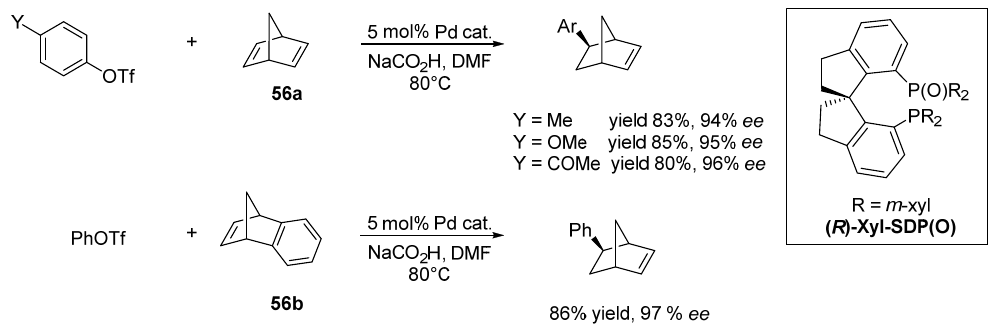
Figure 28 . Asymmetric hydroarylation catalyzed by Pd/(R)-Xyl-SDP(O).